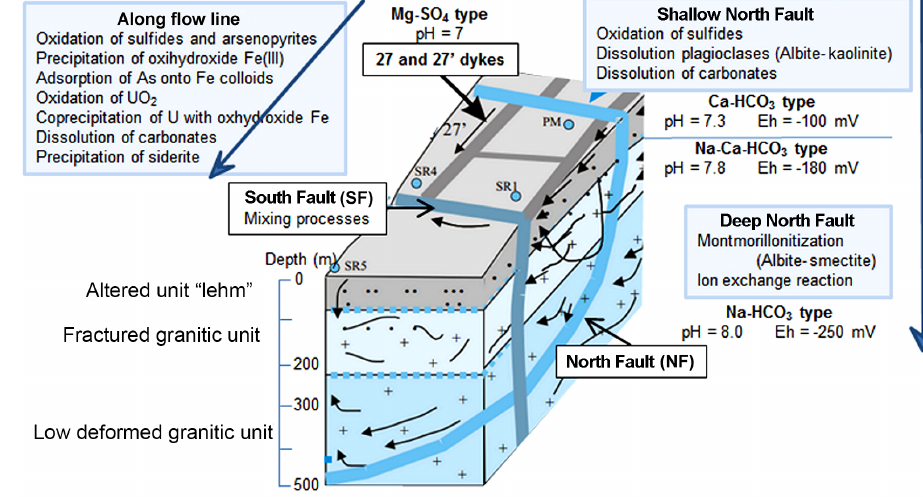
Figure 3. Groundwater hydro-geochemical behavior model of the Ratones aquifer-mine system (modified from Gómez, 2002).